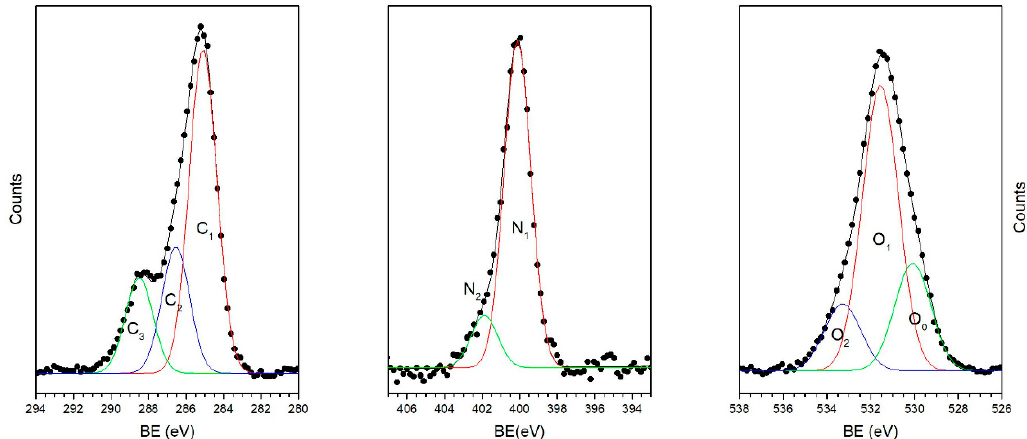
Figure 3. The C1s, N1s and O1s spectra of sample Ti-HAP after SAP adsorption at pH 4 and curve-fitting analysis. Markers represent experimental points, lines calculated spectra and fitting components.